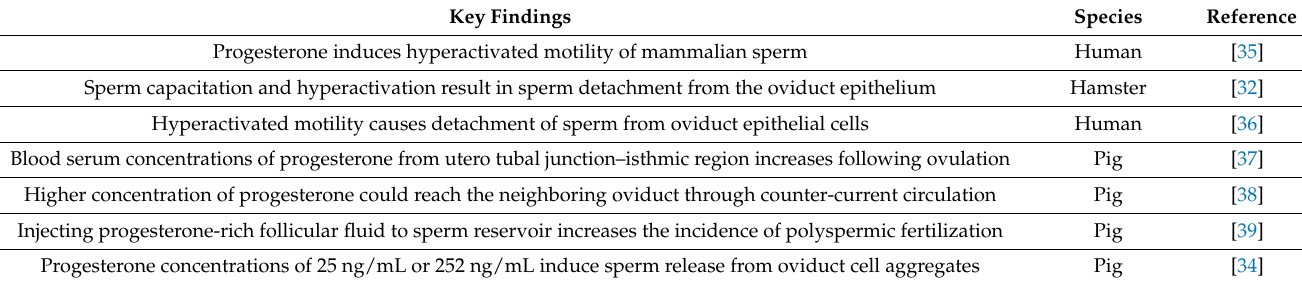
Table 1. Summary of key